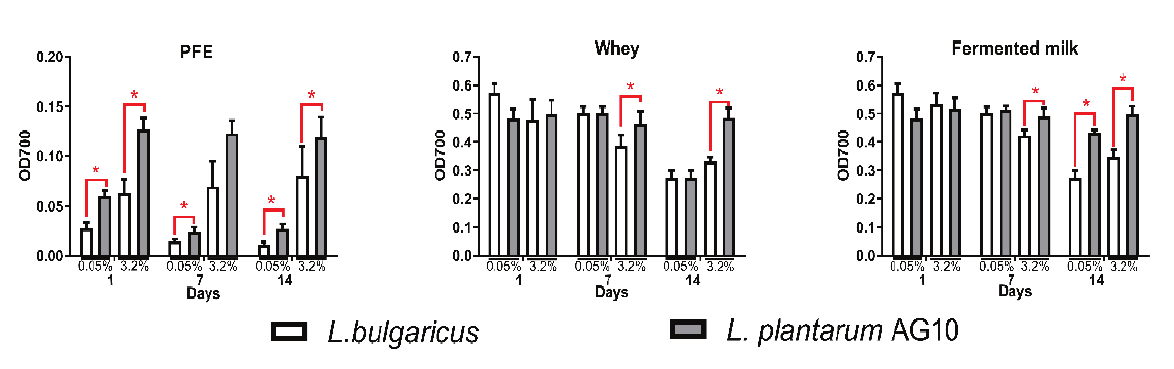
Figure 4. Antioxidant potentials of the protein-free extract (PFE), whey, and whole fermented milk obtained with either L. bulgaricus (shown in white) or L. plantarum AG10 (shown in gray) measured by the Ferric reducing antioxidant power (FRAP) assay after 1, 7, and 14 days of storage. Asterisks show a significant difference at p < 0.05. The % of initial fat in the milk is shown under the x-axis.